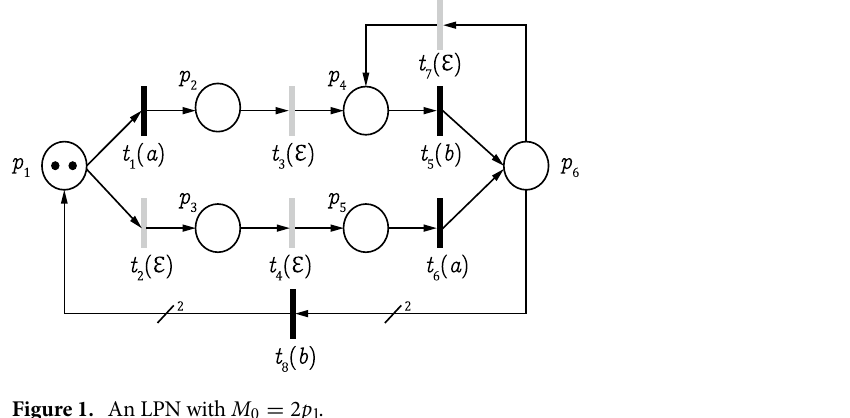
Figure 1. An LPN with M 0 = 2 p 1